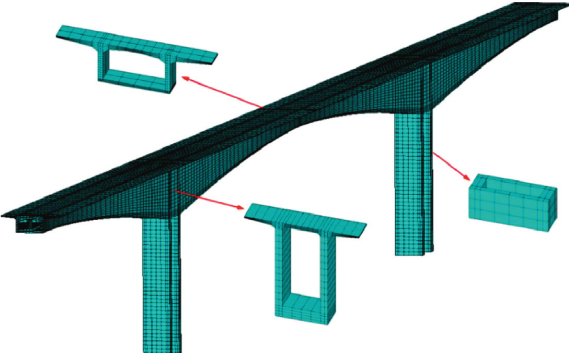
Figure 18: FEM of the auxiliary shipping channel bridge of the SuTong